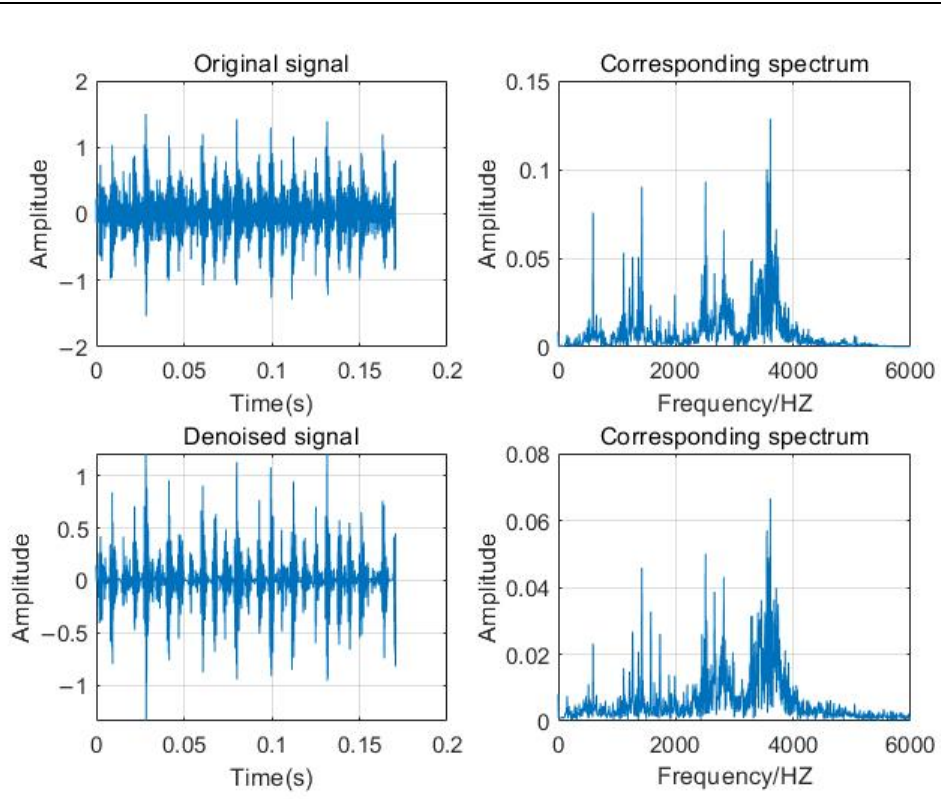
Figure 6. Waveform and spectrum of inner circle fault signal.